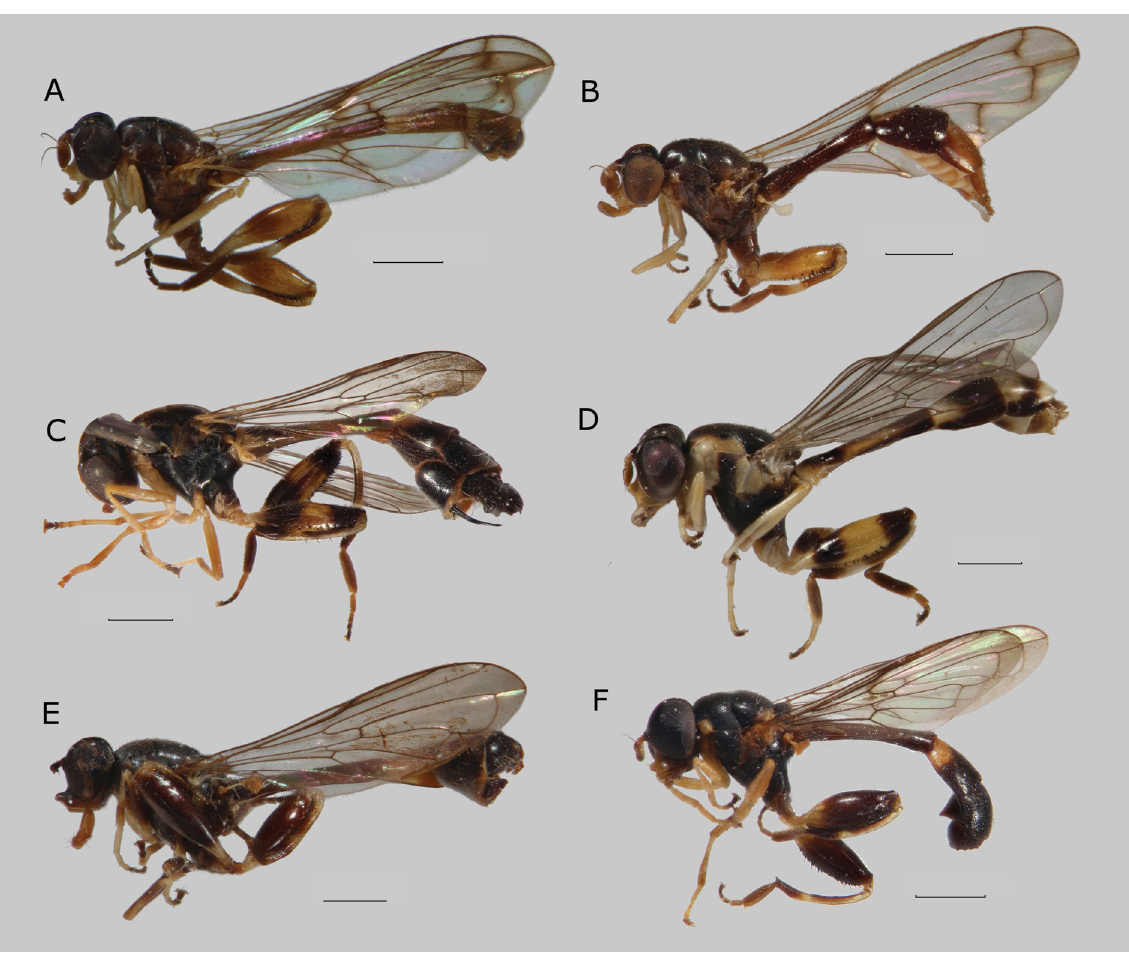
Fig. 35. Habitus, lateral view. A . Sphegina (Asiosphegina) for fi cata Hippa, van Steenis & Mutin, 2015, paratype, ♂ , Myanmar. B . S. (A.) for fi cata , paratype, ♀ , Myanmar. C . S. (A.) furcillata sp. nov., holotype, ♂ , Vietnam. D . S. (A.) cf. furcillata sp. nov., ♀ , Vietnam. E . S. ( A.) furva Hippa, van Steenis & Mutin, 2015, paratype, ♂ , Myanmar. F . S. ( A.) ghatsi sp. nov., holotype, ♂ , India. Scale bars = 1.0